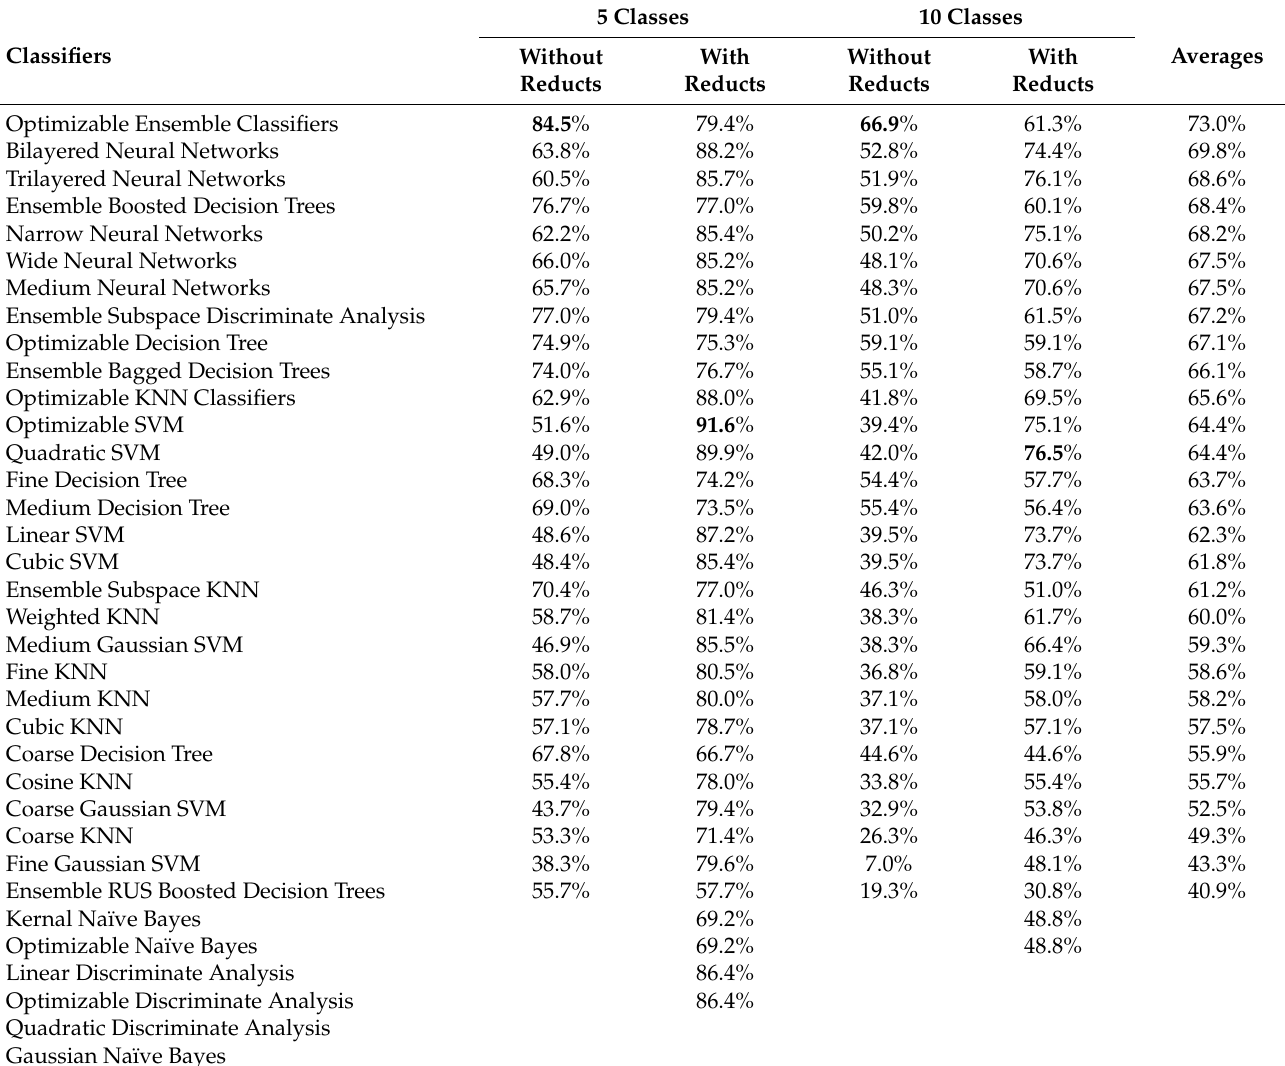
Table 8. Class prediction rates of the TU